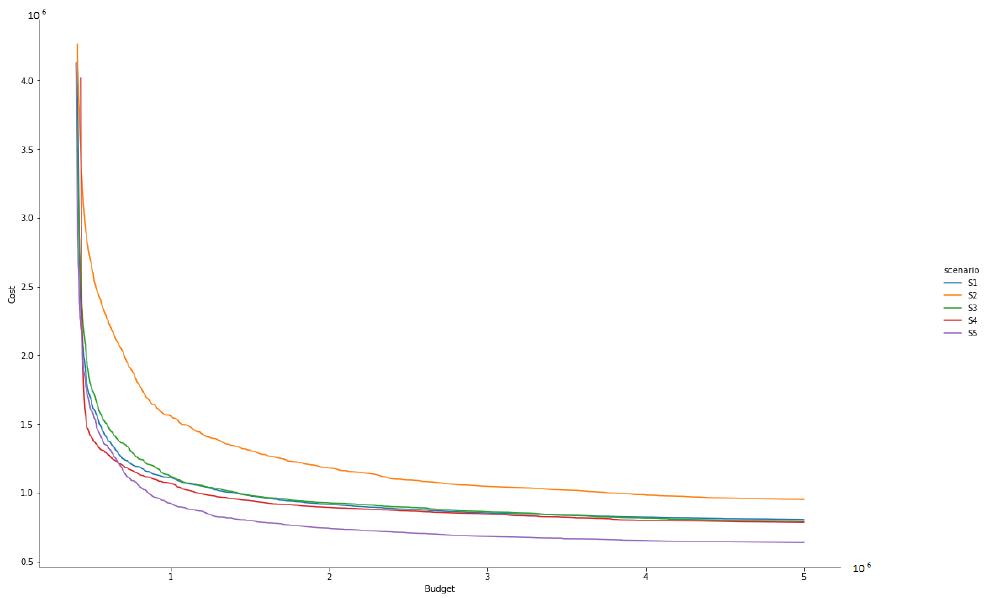
Figure 20. Scenarios on the Hungarian